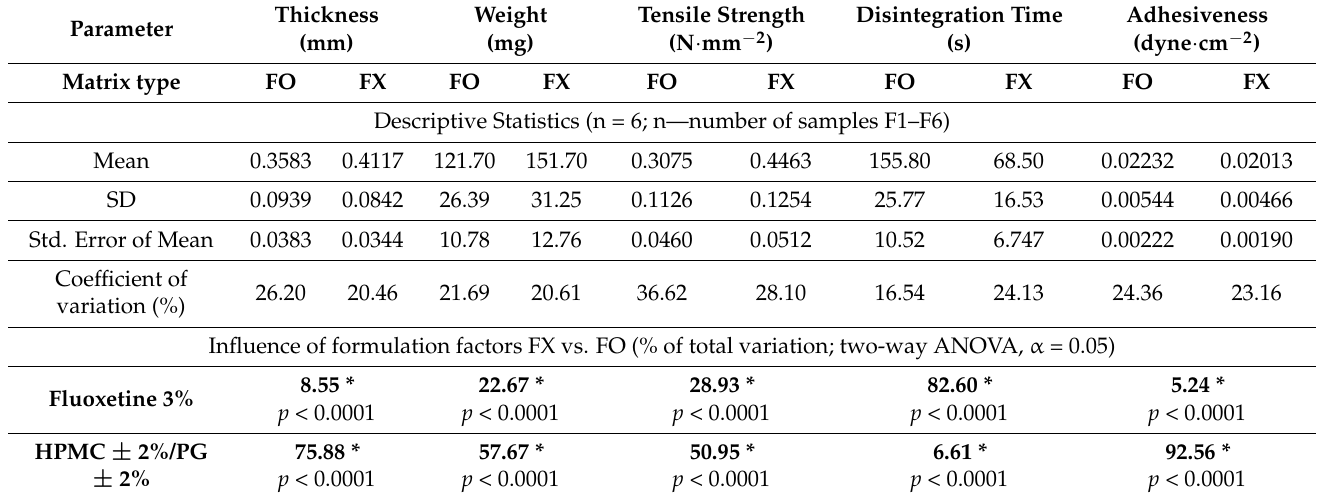
Table 8. The results of descriptive statistical analysis and variance of the two formulations types FX versus FO.